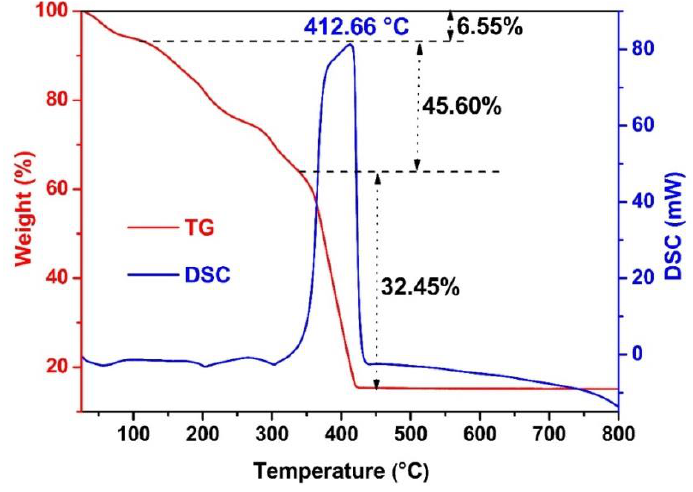
Figure 6. TGA – DSC curves of transformation from NiFe-bimetallic MOFs to NiFe 2 O 4 . Figure 6. TGA–DSC curves of transformation from NiFe-bimetallic MOFs to NiFe